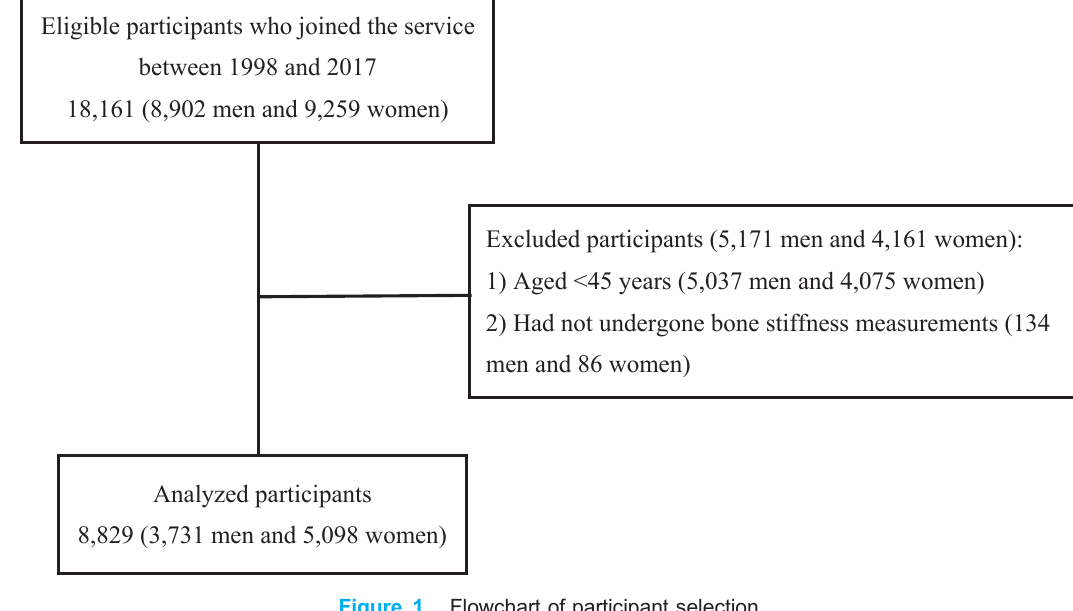
Figure 1. Flowchart of participant selection